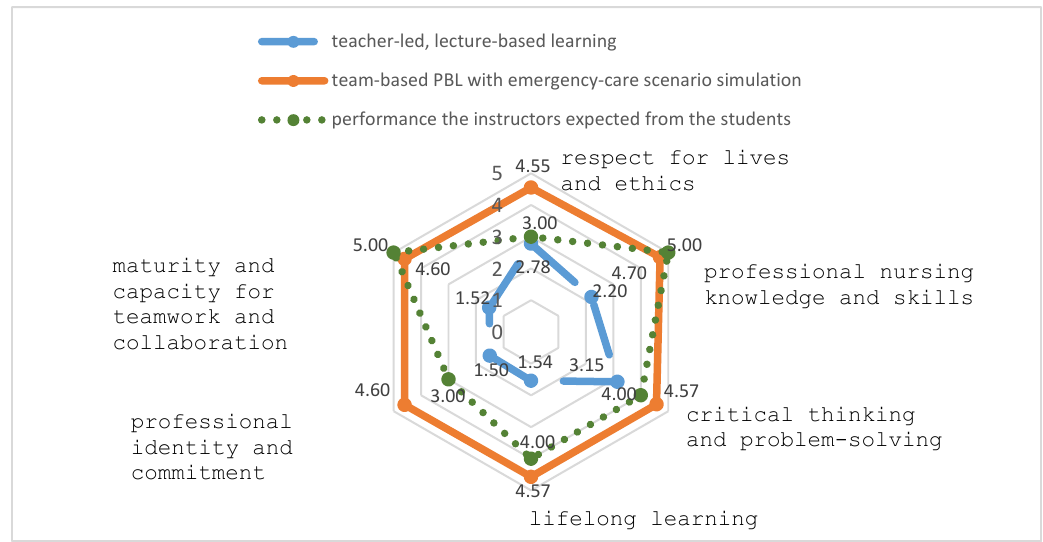
Figure 1. A comparison of the nursing students’ performance in six core competencies.